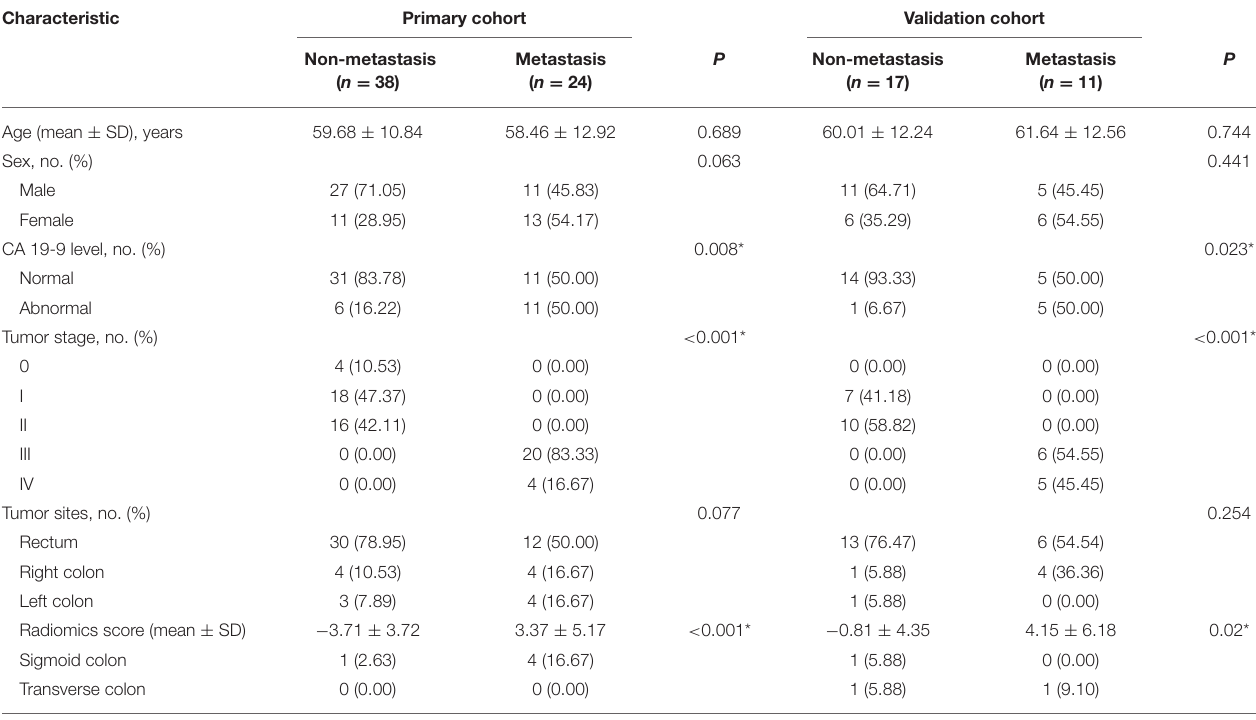
TABLE 1 | Characteristics of patients in the primary and validation cohorts.